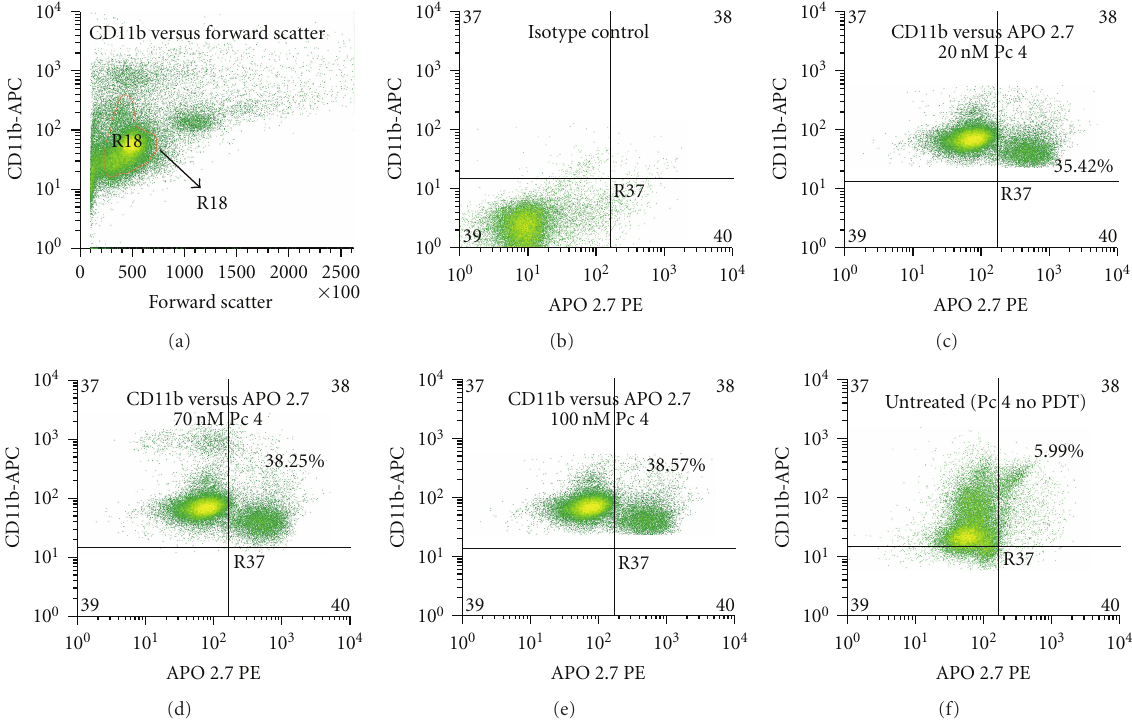
Figure 4: Representative flow cytometric histograms of the induced apoptosis of CD11b + monocytes treated with Pc 4-PDT. Total blood was obtained from patients diagnosed with Sezary syndrome. The histograms shown were taken from a single patient with SS. PBMCs were isolated, treated with Pc 4, and stained as mentioned previously in the Methods section. Monocytes were identified by their high CD11b + expression ( y -axis) and forward scatter ( x -axis) as shown in yellow (Region R18) in (a). Levels of apoptosis in all three Pc 4-PDT doses were then further analyzed from this population. As shown in (c), (d), and (e), levels of apoptosis were similar in the three treatment groups. Apoptosis induction in the untreated group is shown in